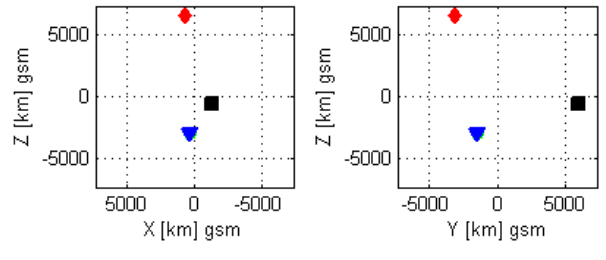
Fig. 7. Relative positions of the Cluster satellites during event 2, on 3 March 2008 at 23:15UT. The figure is drawn in GSM coordinates. C1 is black square, C2 red diamond, C3 green circle (under the C4 symbol) and C4 blue